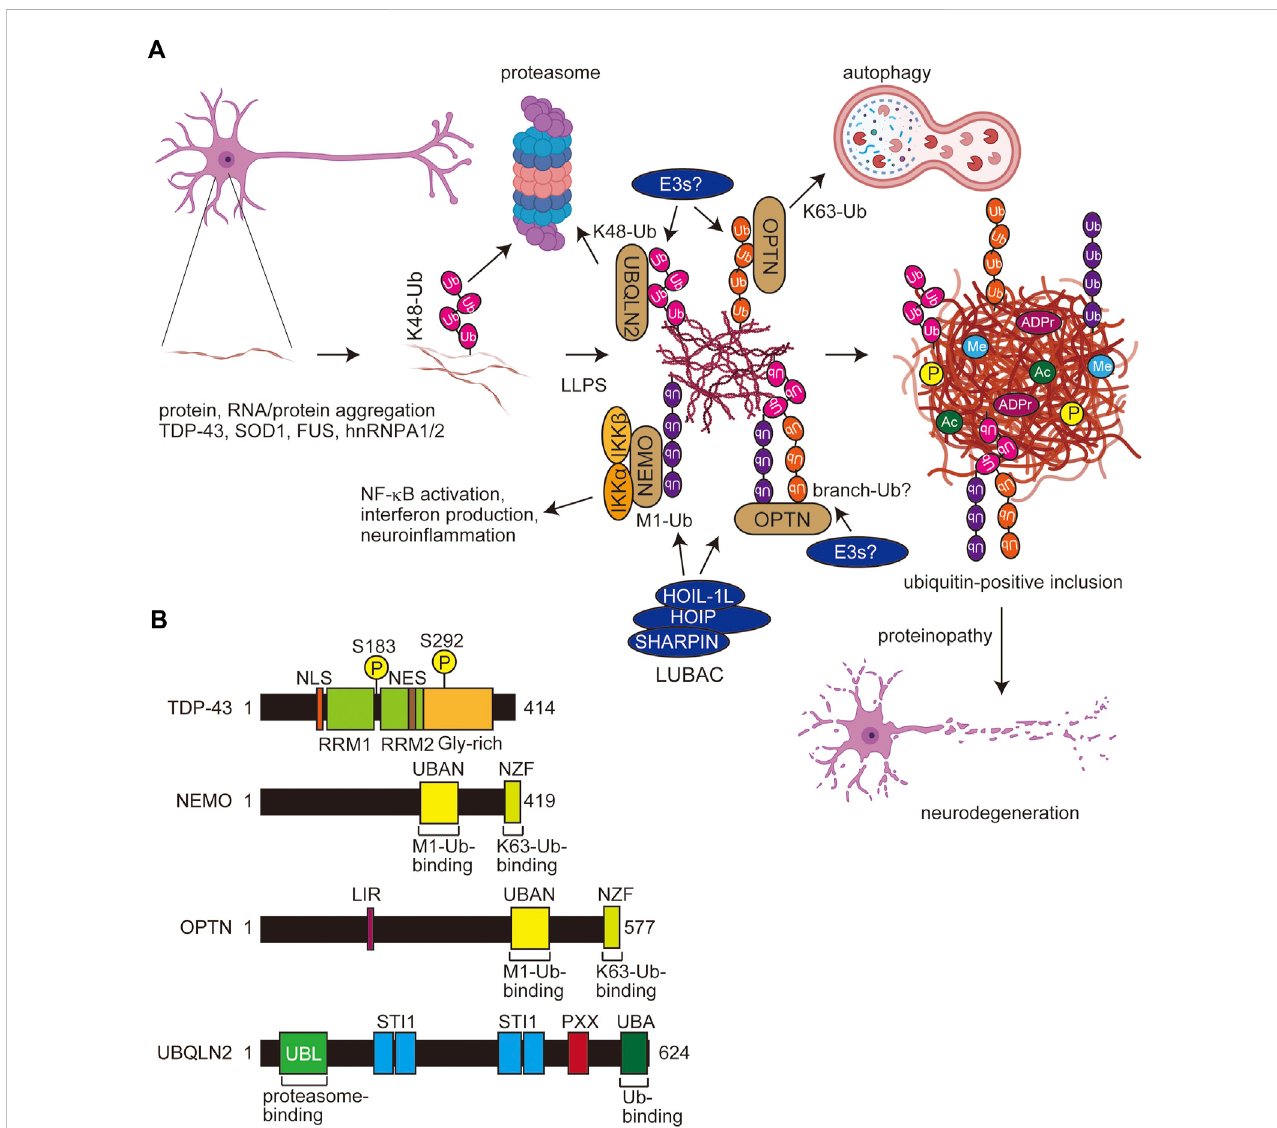
FIGURE 4 Scheme for PTM-mediated aggregate formation in ALS and domain structures of related molecules. (A) In ALS, the misfolding of aggregating proteins such as TDP-43, SOD1, FUS, and hnRNPA1/2 forms thin inclusions, and various PTMs including multiple ubiquitinations facilitate the LLPS and expansion of aggregates. Several E3s, including LUBAC and ubiquitin-binding proteins such as UBQLN2, OPTN, and NEMO, affect the proteasomal and autophagic degradation and the in fl ammatory response. Finally, the accumulated protein aggregates exert proteinopathy leading to cell death. Ub, ubiquitin; P, phosphorylation; Me, methylation; ADPr, ADP-ribosylation. (B) Domain structures of TDP-43, NEMO, OPTN, and UBQLIN2. NLS, nuclear localization signal; RRM, RNArecognitionmotif;NES, nuclear export signal; UBAN,ubiquitin bindingin ABIN and NEMO; NZF, Npl4-type zinc fi nger; LIR, LC3-interacting region; UBL, ubiquitin-like; STI1, stress-induced protein 1; PXX, Pro-rich repeat; UBA,